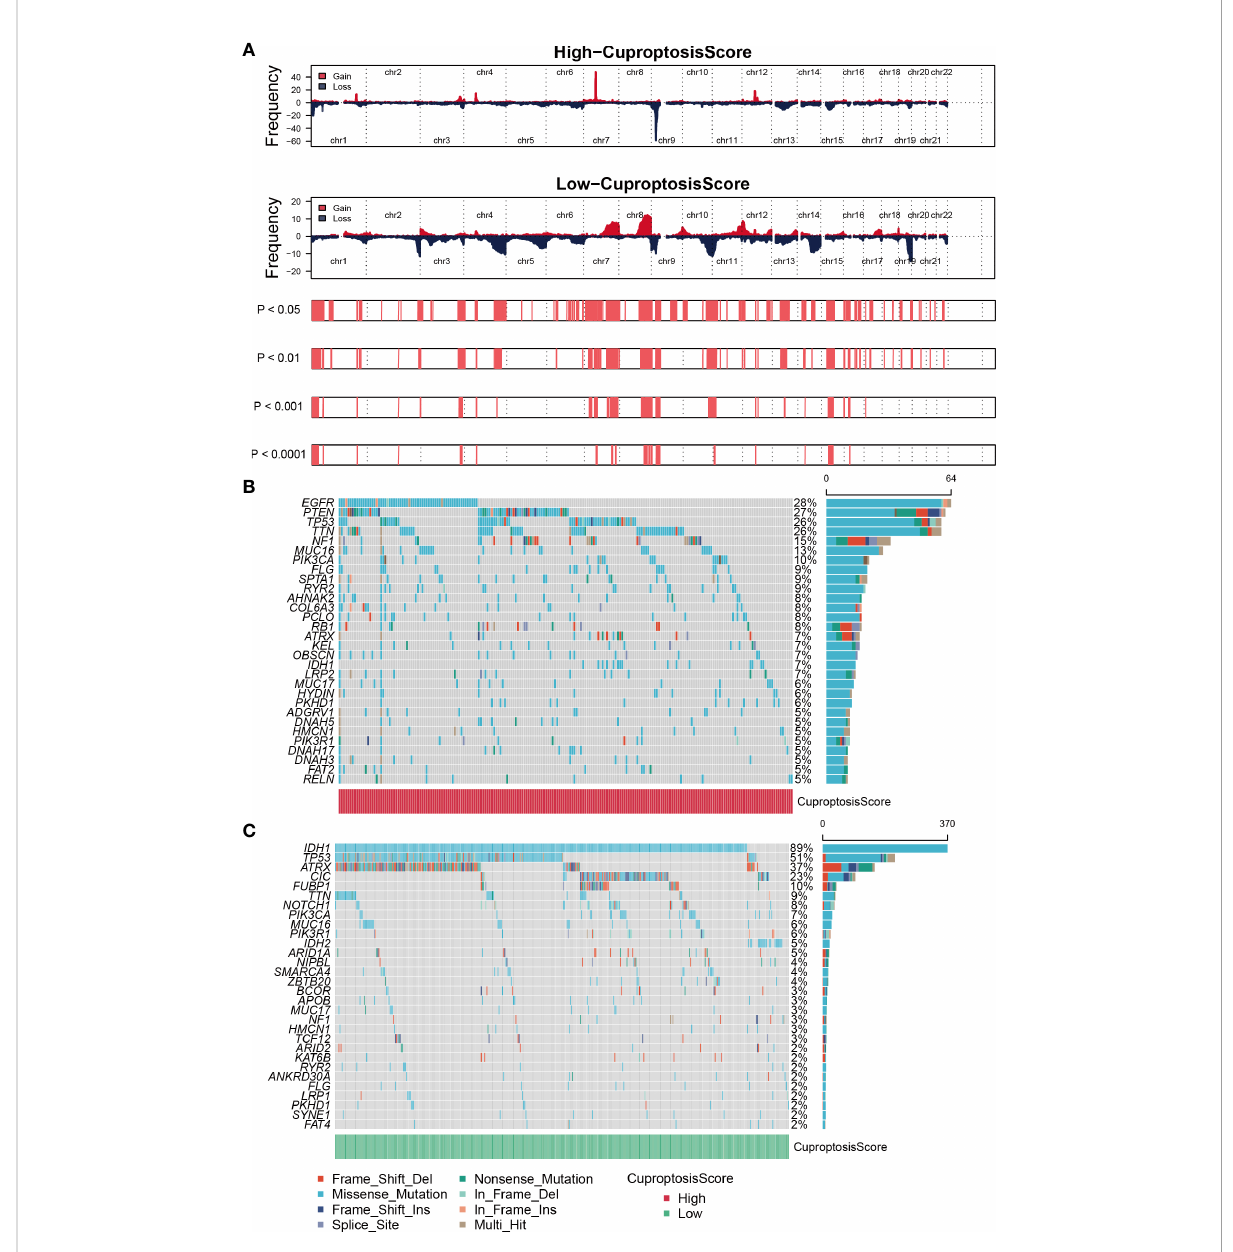
FIGURE 4 Genomic mutation analysis for cuproptosis-signature. (A) Genomic characterization landscape of high-CuproptosisScore or low- CuproptosisScore subgroups. (B) Gene mutation frequency in high-CuproptosisScore. (C) Gene mutation frequency in